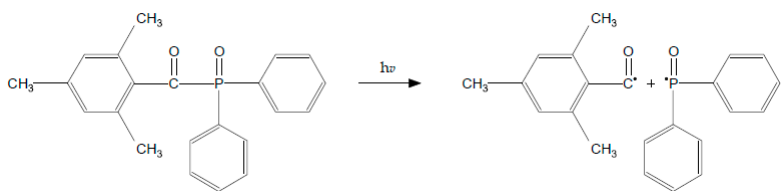
Figure 1. Alpha-cleavage of photoinitiation mechanism of trimethylbenzoyl-diphenylphosphine oxide (TPO).